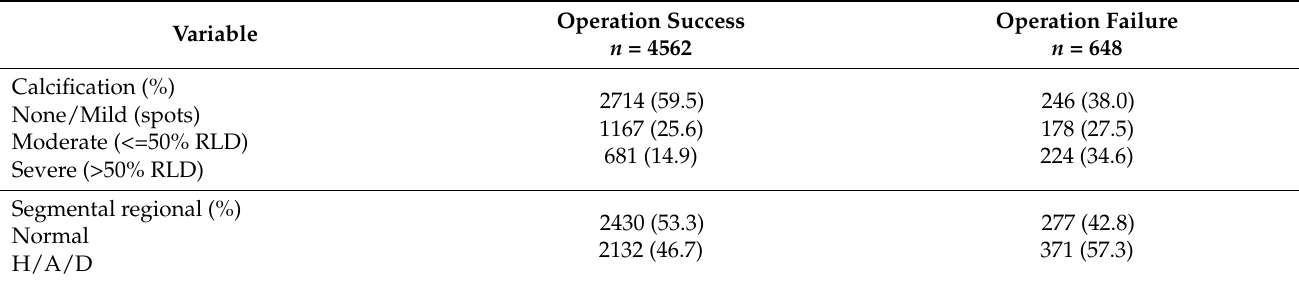
Table A3. Descriptive characteristics for the test dataset ( n = 5210). For quantitative variables, the mean and standard deviation (in brackets) are displayed. For qualitative variables, the frequencies and corresponding percentages (in brackets) are displayed for each